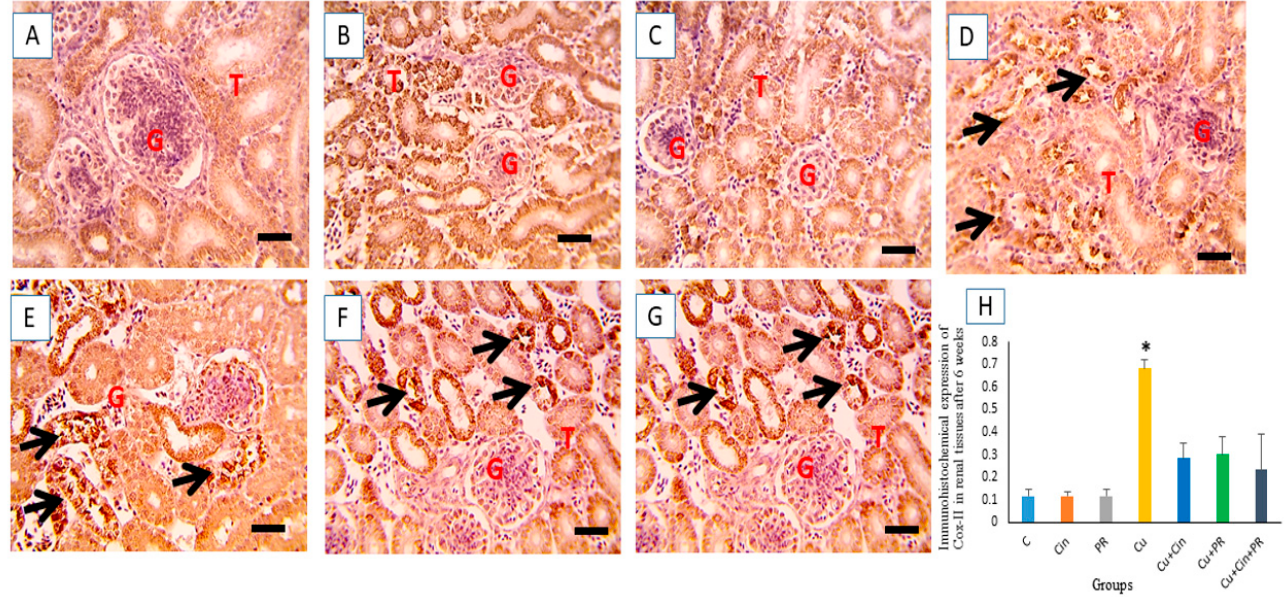
Figure 9. Immunohistochemical staining for COX-II in the chickens’ kidney after 6 weeks of the experiment. ( A – C ) control group ( C ), cinnamon group (Cin), and probiotic group (PR): showing minimal positive bright brown tubular expression of COX-II. ( D ) Copper group (Cu): strong positive COX-II immune staining (black arrow). ( E , F ) Cu + Cin, and Cu + PR groups: displaying moderate COX-II reaction. ( G ) Cu + Cin + PR group: declaring significant reduction ( p < 0.05) in COX-II-positive cells compared to Cu group. ( H ) Showing the quantification of COX-II in the renal tissues in various groups. Data are presented as mean ± SEM. * Significance compared to control ( p < 0.05). Scale bar = 50 µm. G, glomeruli; T, tubules. Table 5. Growth performance of broiler chickens treated with copper, cinnamon extract, and probiotic.